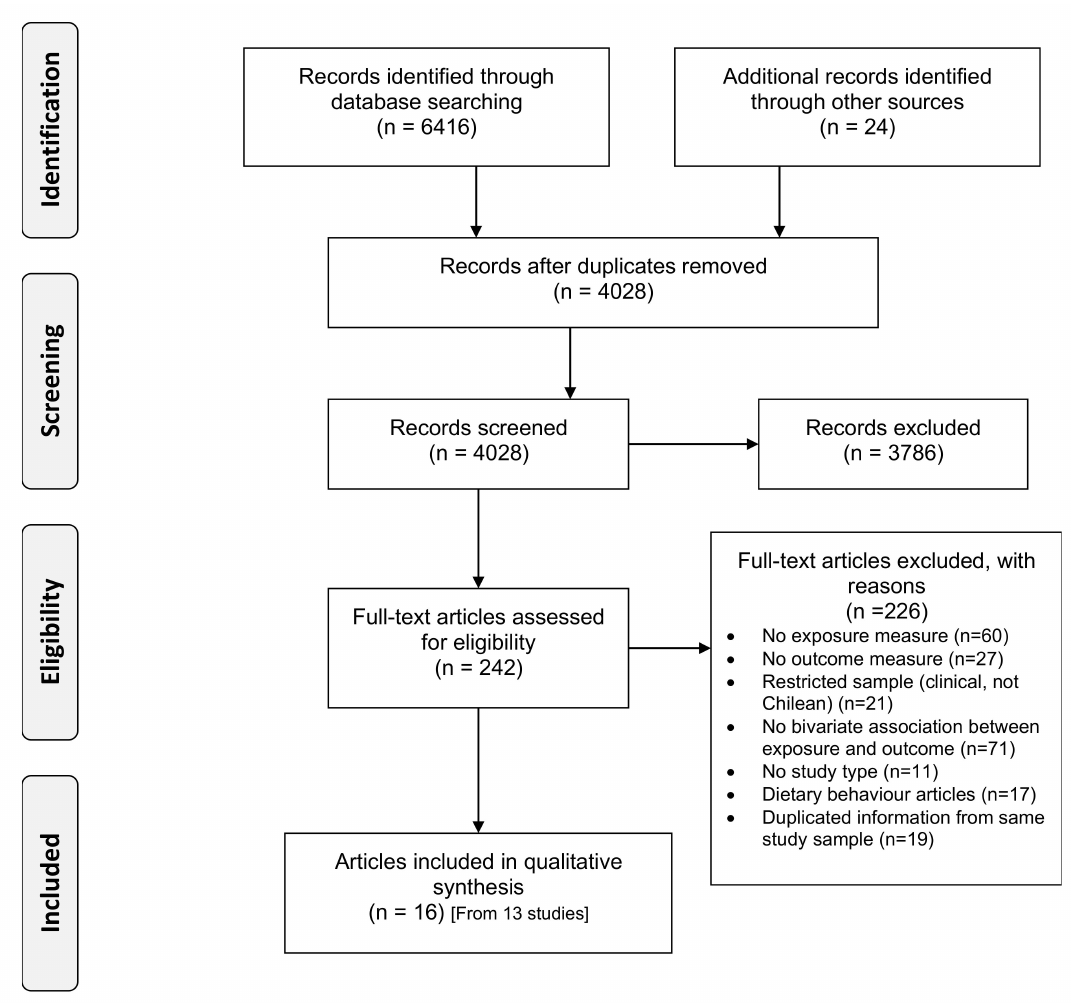
Figure 1. Preferred Reporting Items for Systematic reviews and Meta-Analyses (PRISMA) flow diagram of literature Scheme